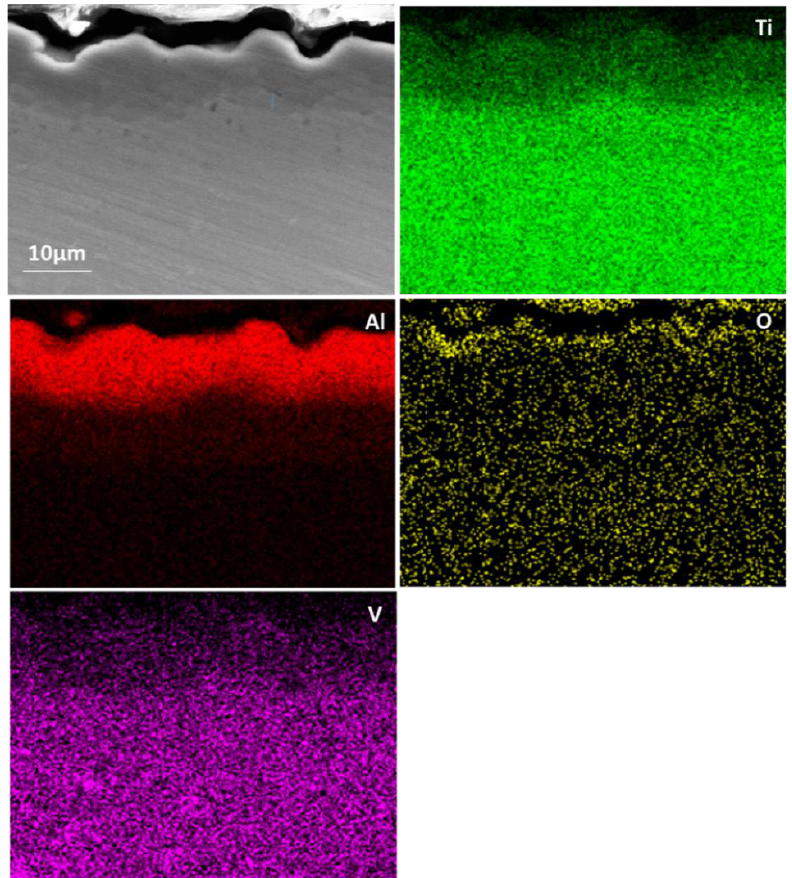
Figure 8. SEM image and EDS mapping for cross-sectioned Ti-6Al-4V aluminised at 1000 °C for 1 h.